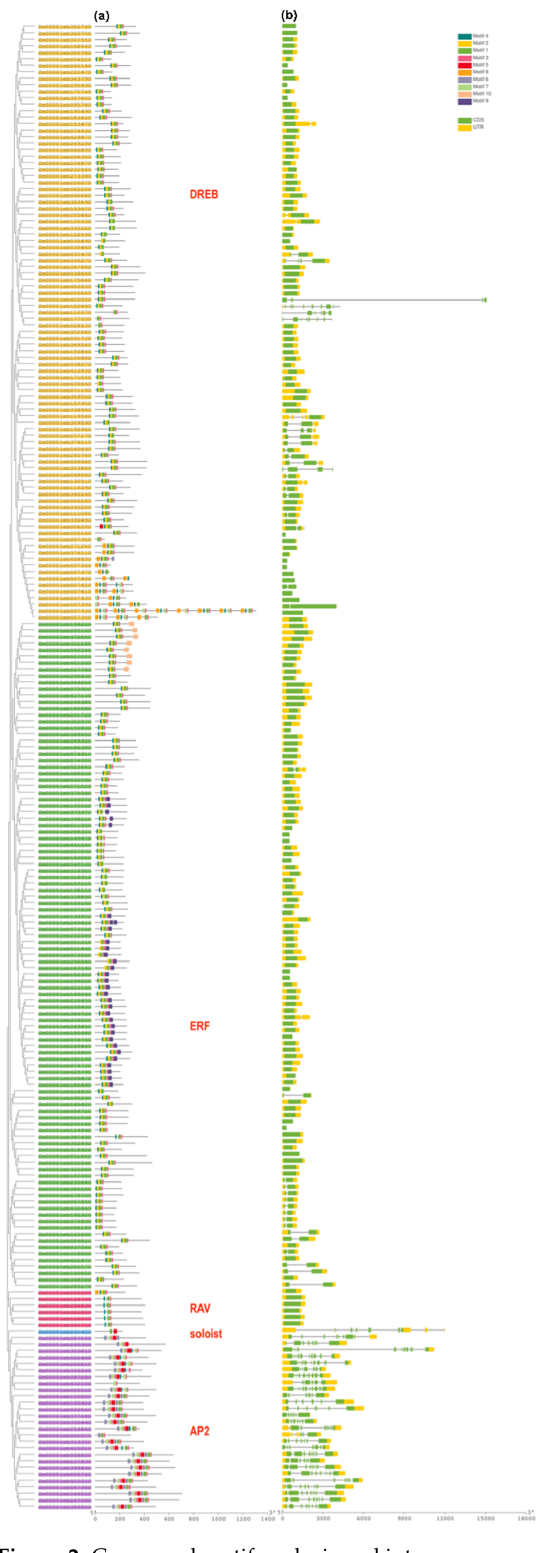
Figure 2. Conserved motif analysis and intron-exon organization of ZmAP2 / ERFs. ( a ) Conserved mo- tifs of different lengths are depicted on the protein map. ( b ) Intron-exon organization of ZmAP2/ERFs. At the base of the figure, relative position is displayed at (kilobase)